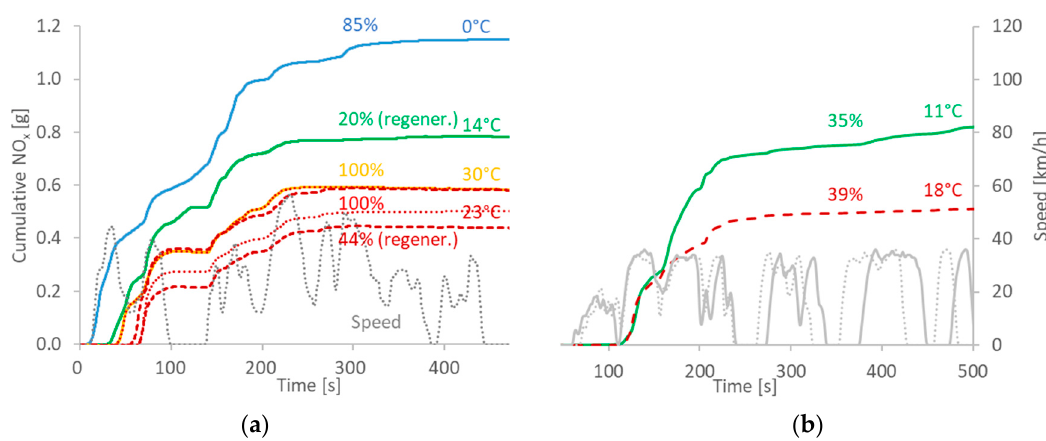
Figure 8. Cumulative NO x emissions at various ambient temperatures: ( a ) laboratory WLTCs; ( b ) on-road Traffic routes. Percentages give the ratio of cumulative NO x after 300 s to the total NO x at the end of the test. In brackets is mentioned if a regeneration event took place at the high speed part of the cycle. WLTC = Worldwide Light-duty Test Cycle.